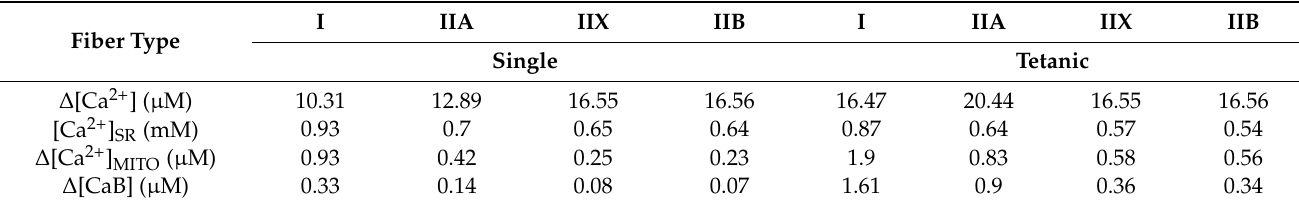
Table 3. Maximum [Ca 2+ ] variations reached during the simulated time intervals of single (60 ms) and tetanic (300 ms) Ca 2+ transients of I, IIA, IIX, and IIB fiber types a